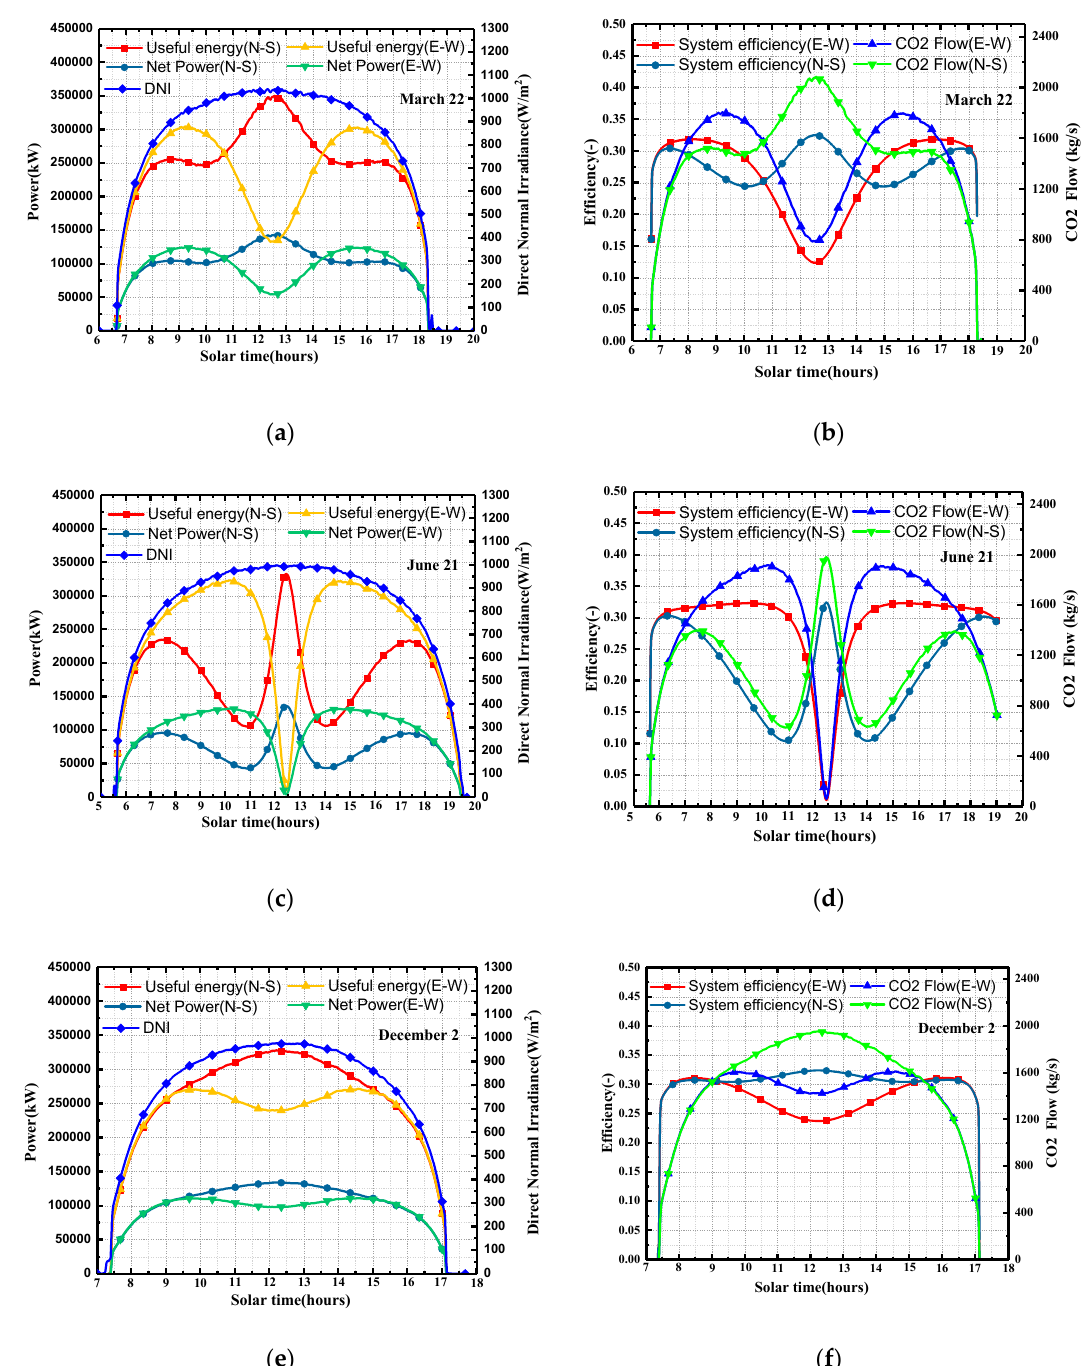
Figure 9. Performance results of the PTC s-CO 2 Brayton cycle in clear-sky conditions on ( a , b ) 22 March, ( c , d ) 21 June, ( e , f ) 2 December.